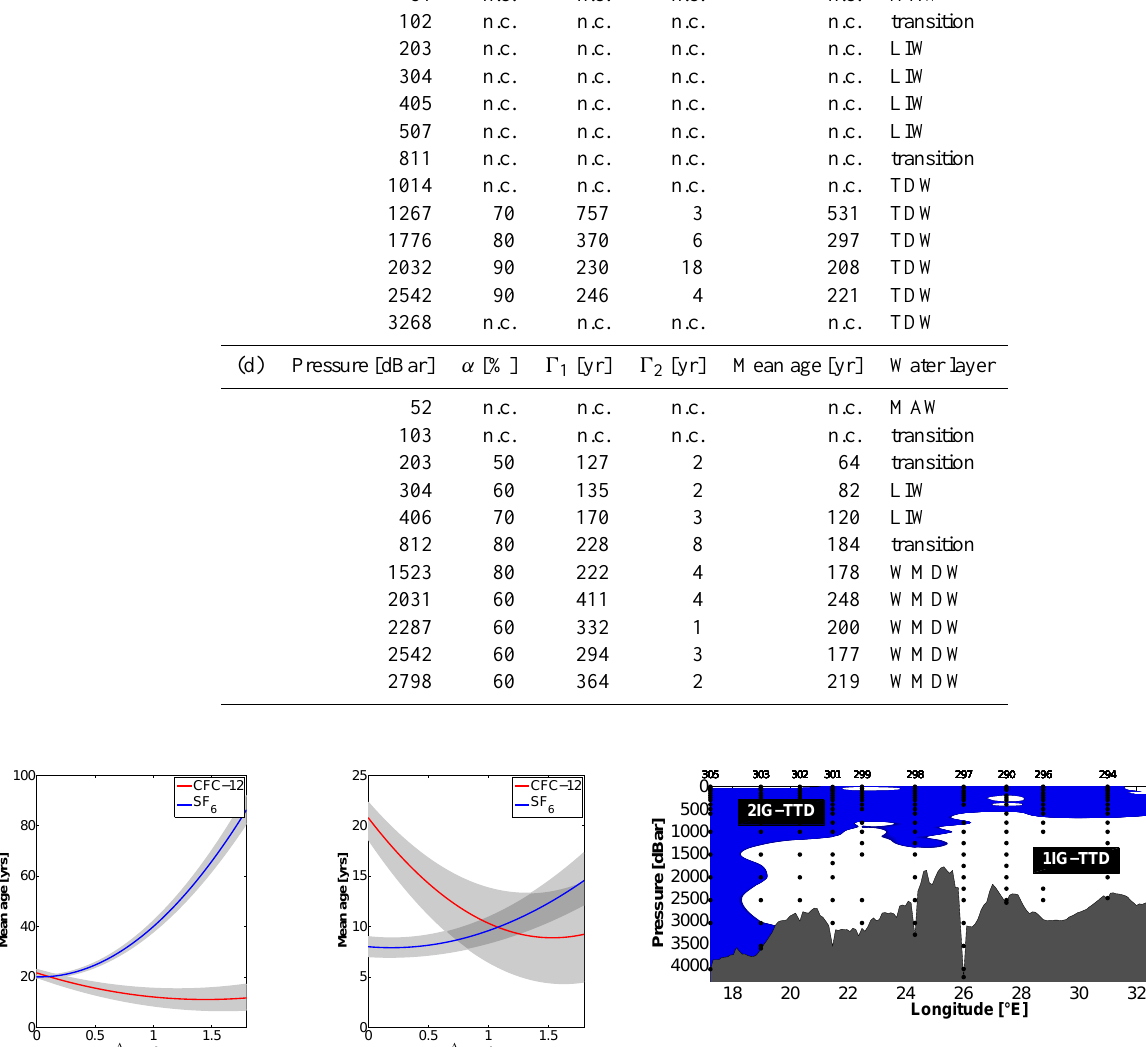
Figure 16. Differences of the tracer age between CFC-12 and SF 6 . Fig. 16: Differences of the tracer age between CFC-12 and SF 6 . The white shading describes tracer age differences below and The white shading describes tracer age differences below and the the blue shading above 10 years. Fig.15:MeanagefunctionsofCFC-12andSF 6 atstation288,( a )intheCretanSeaat2030mdepthand( b )atstation313in blue shading above 10 theAdriaticSeaat1094mdepthwithanerrorrangeof4%analyticalerror. Figure 15. Mean age functions of CFC-12 and SF 6 at station 288, (a) in the Sea of Crete at 2030m depth and (b) at station 313 in the Adriatic Sea at 1094m depth with an error range of 4% analytical error.